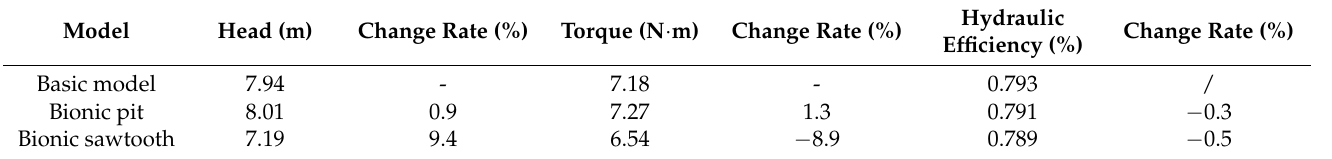
Table 2. External characteristic parameters of different models under design conditions.